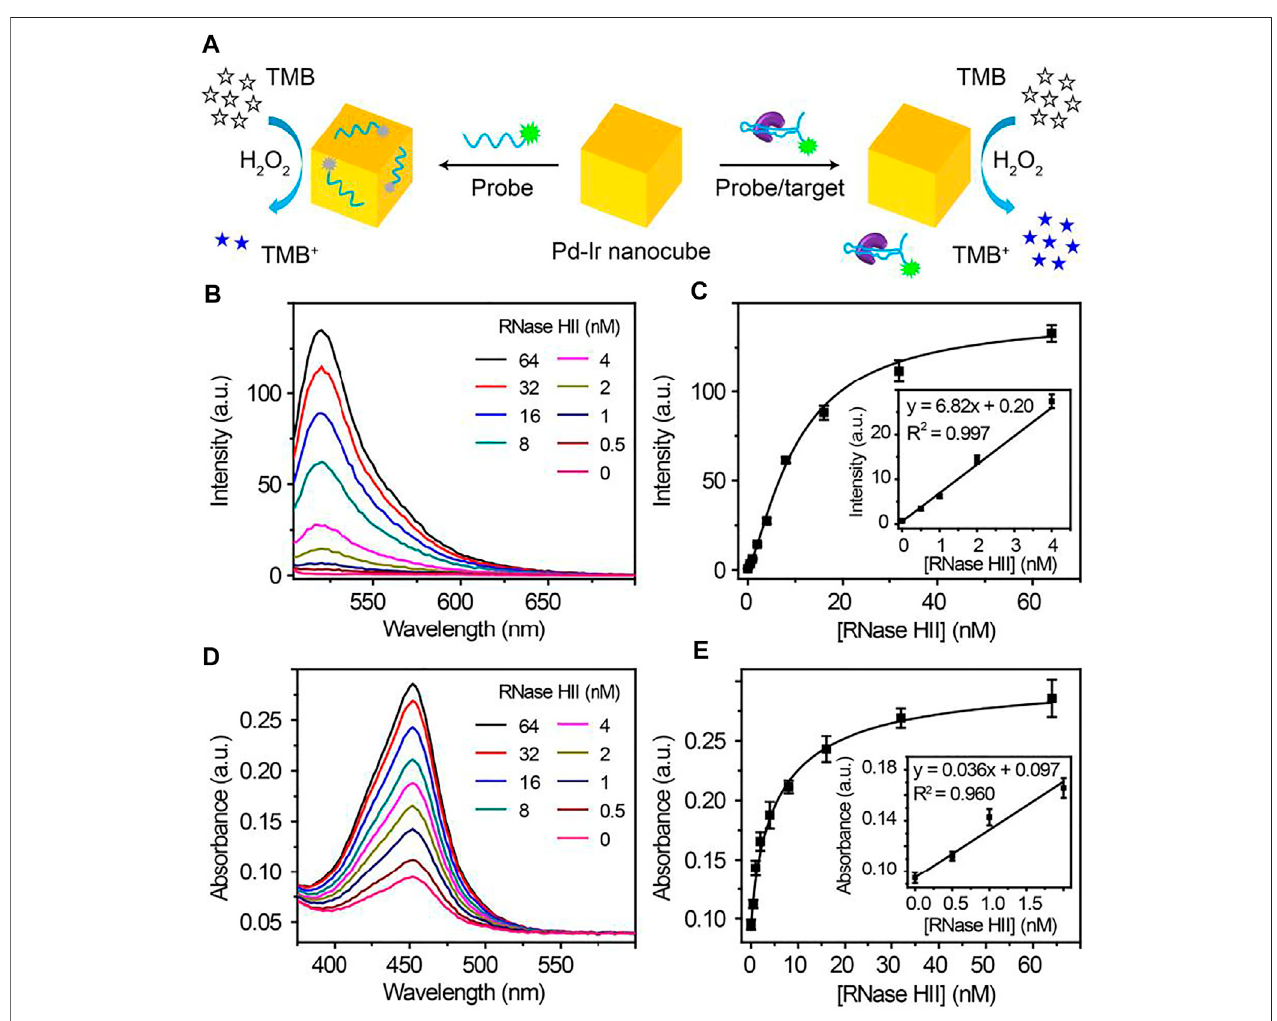
FIGURE 5 | (A) Schematic illustration of fl uorescent and colorimetric detection of C. dif fi cile RNase HII using Pd-Ir nanocubes and fl uorescein-labelled aptamers. (B) Fluorescence curvesand (C) plot(inset: linearresponse)ofcorresponding fl uorescenceintensityat522 nm towardsdifferentconcentrationsof C.dif fi cile RNaseHII; LOD (cid:1) 0.15 nM. (D) Absorption curves and (E) plot (inset: linear response) of the corresponding absorbance at 450 nm towards different concentrations of C. dif fi cile RNase HII; LOD (cid:1) 0.29 nM. LOD (limit of detection) is de fi ned as the concentration of targets corresponding to a signal that is three times the standard deviation higher than zero calibrators (n (cid:1)